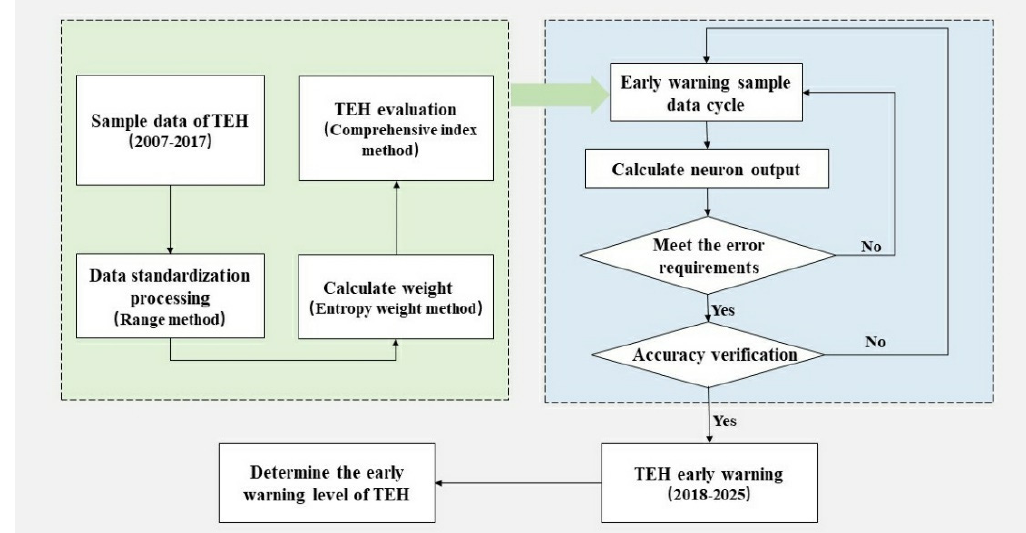
Figure 4. Forecast and early warning flow chart.